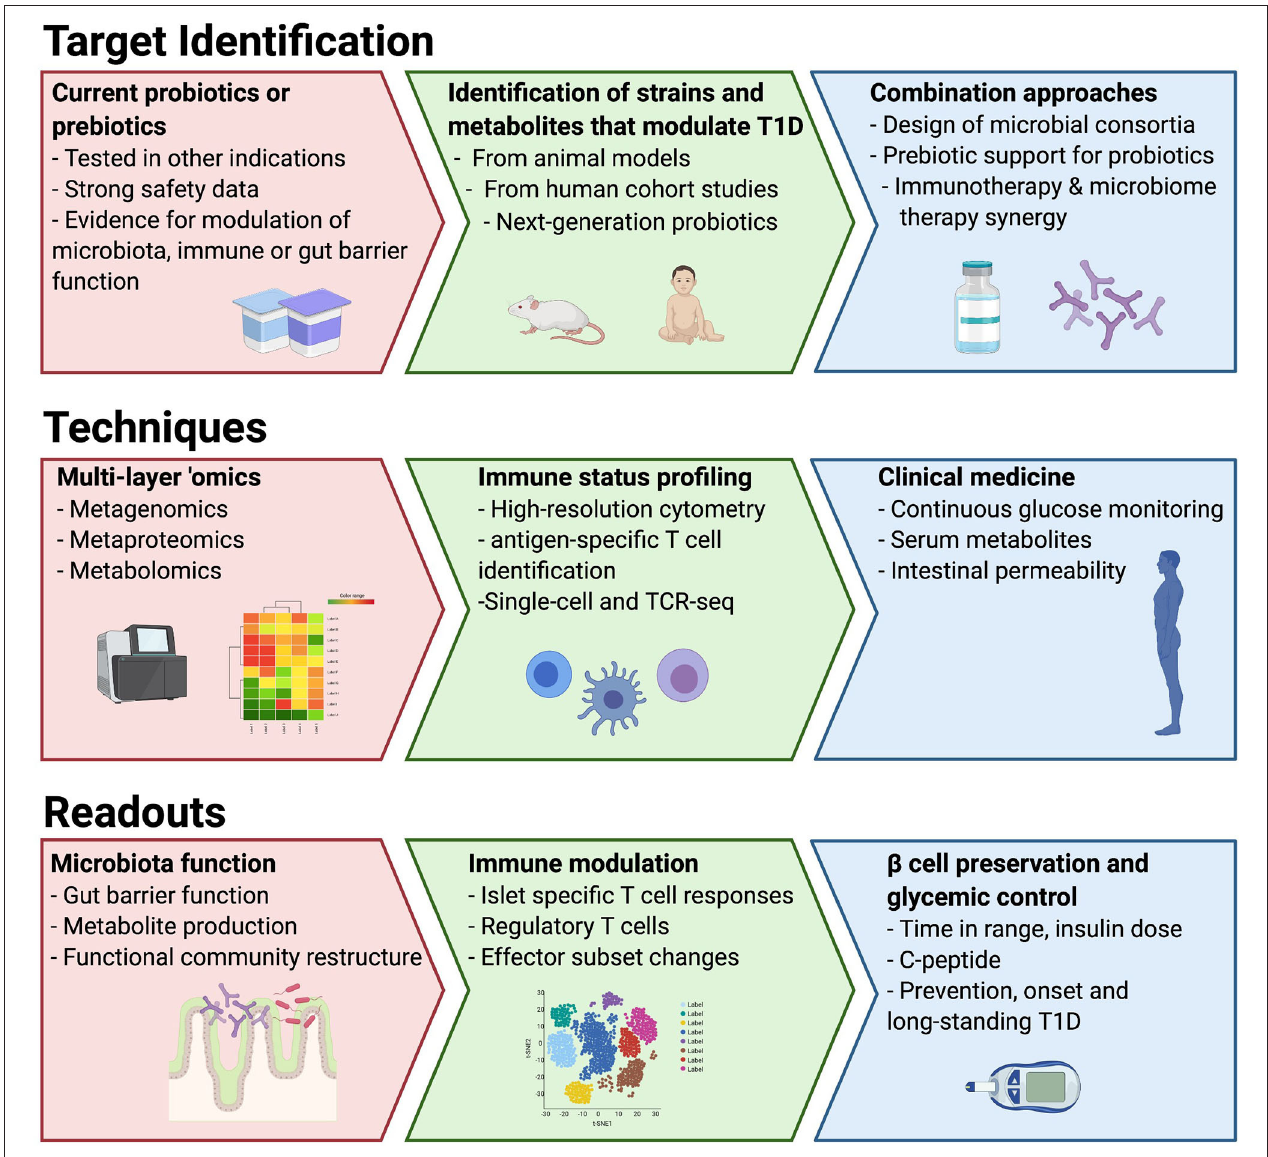
FIGURE 1 | Proposed roadmap to utilize different approaches, model systems and techniques to drive to microbiota-targeted therapeutics in